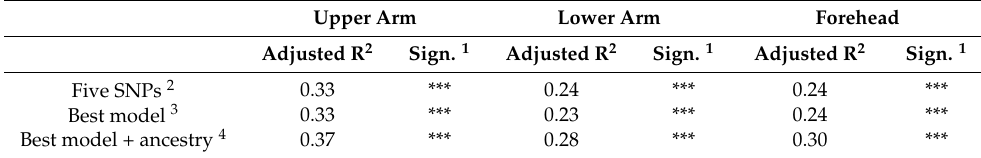
Table 2. Multiple loci correlations with skin pigmentation on the upper arm, lower arm, or forehead in 299 Pakistani individuals from three subpopulations (Baloch, Pashtun, and Punjabi). Upper Arm Lower Arm Forehead Adjusted R